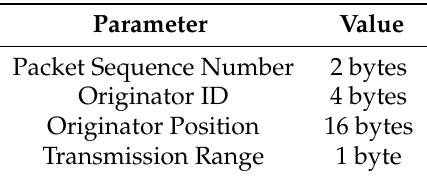
Table 1. Hello packet